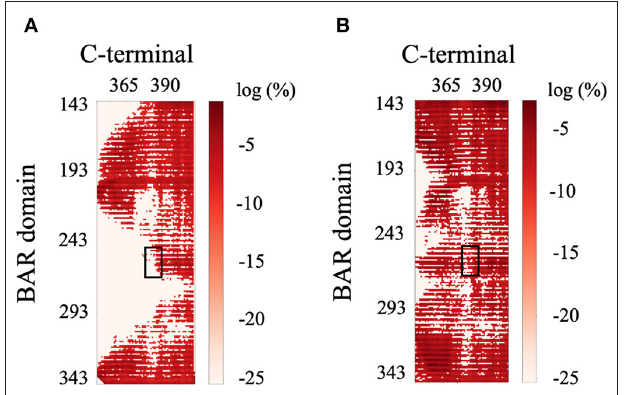
FIGURE 9 | Contact map of BAR and C-terminus interactions. (A) C-terminus 1 and BAR 1 interactions. (B) C-terminus 1 and BAR 2 interactions. Black boxes indicated interactions between the key positively charged residues on the BAR domain (K251, K252, K257, K266, and K268) and the negatively charged residues of the C-terminus (D380-D389).